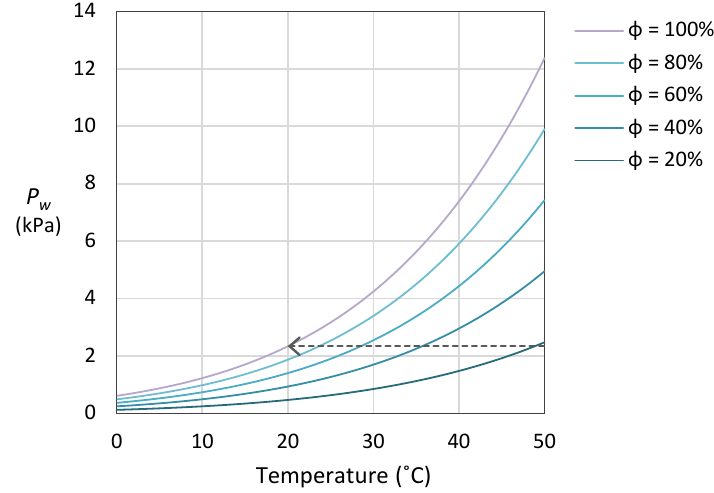
Figure 1. Vapor pressure P w = φ P sat as a function of temperature at a range of relative humidities, using the empirical formula P sat ≈ ( 611.21Pa ) exp [ 17.502 T / ( 240.97 + T )] , where T is measured in ◦ C [41]. The horizontal dashed line illustrates the progressive increase in φ along an idealized cooling pathway with constant vapor